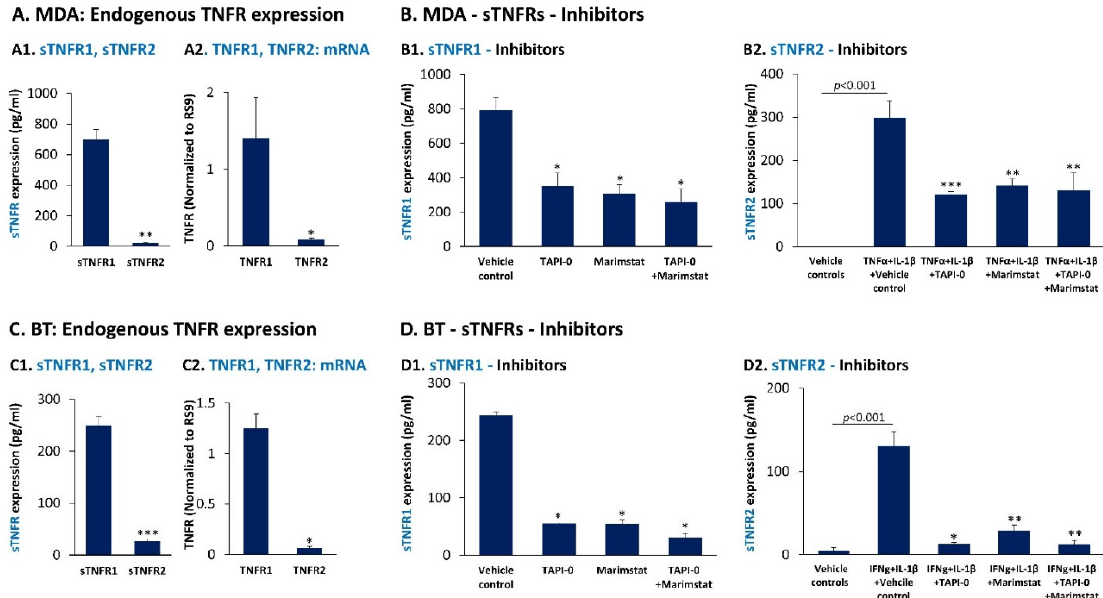
Figure 6. MDA ‐ MB ‐ 231 and BT ‐ 549 cells express higher levels of cell ‐ derived sTNFR1 than sTNFR2, Figure 6. MDA-MB-231 and BT-549 cells express higher levels of cell-derived sTNFR1 than sTNFR2, and both soluble receptors are shed in an ADAM17 ‐ dependent process. ( A , C ) The constitutive cell ‐ and both soluble receptors are shed in an ADAM17-dependent process. ( A , C ) The constitutive cell- derived expression levels of sTNFR1 and sTNFR2 were determined by ELISA in CM of MDA-MB-231 cells (MDA) ( A1 ) and BT-549 cells (BT) ( C1 ), after 48 h of cell growth. In parallel, mRNA levels of TNFR1 and TNFR2 were determined by qPCR in MDA cells ( A2 ) and BT cells ( C2 ), after 5 h of cell growth. In each panel, a representative experiment of n = 3 is presented. *** p < 0.001, ** p < 0.01, * p < 0.05. ( B , D ) Cell-derived levels of sTNFR1 ( B1 , D1 ) and sTNFR2 ( B2 , D2 ) were determined in a 48 h CM of MDA cells ( B1 , B2 ) and in BT cells ( D1 , D2 ) following treatment with marimastat (3.3 µ g/mL), TAPI-0 (5 µ g/mL) and both inhibitors together (same concentrations), as indicated.